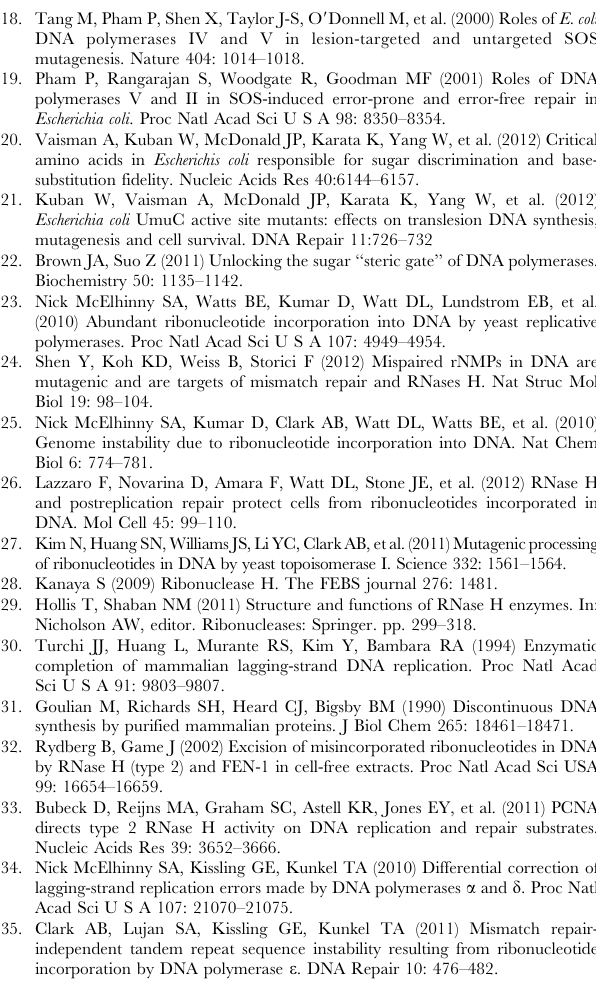
recA730 lexA (Def) D umuDC strains either harboring pGB2 vector, or expressing pol V variants. (PDF) Figure S3 Western blot of the a -subunit of pol III holoenzyme in rnh + and D rnhB strains. The a -subunit of pol III holoenzyme was detected in whole cell extracts from E. coli rnh + or D rnhB strains using mouse monoclonal antibodies raised against the a -subunit. The band intensities shown at the bottom of the gel were calculated as the percent of the band intensity observed in the rnh + dinB + strain (RI 2 relative intensity).